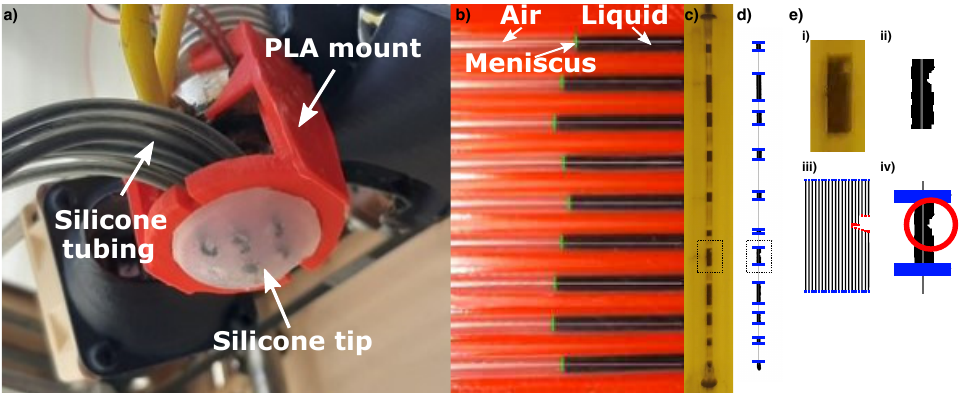
Figure 2. ( a ) The ESPRESS.0 mounted to a Cartesian arm, with the tubes channelled to pass in front of a camera. ( b ) The camera monitors the position of the liquid the channels against a red housing. ( c , d ) A single channel against a yellow housing has multiple menisci to increase the tracking range and smooth any noise. The image is processed to produce the menisci positions in blue. ( e ) Marked section of c and d showing the process (i) from camera frame (ii) converted to monochrome (iii) splitting to 20 vertical strips and finding edges (iv) to filtering out noise and